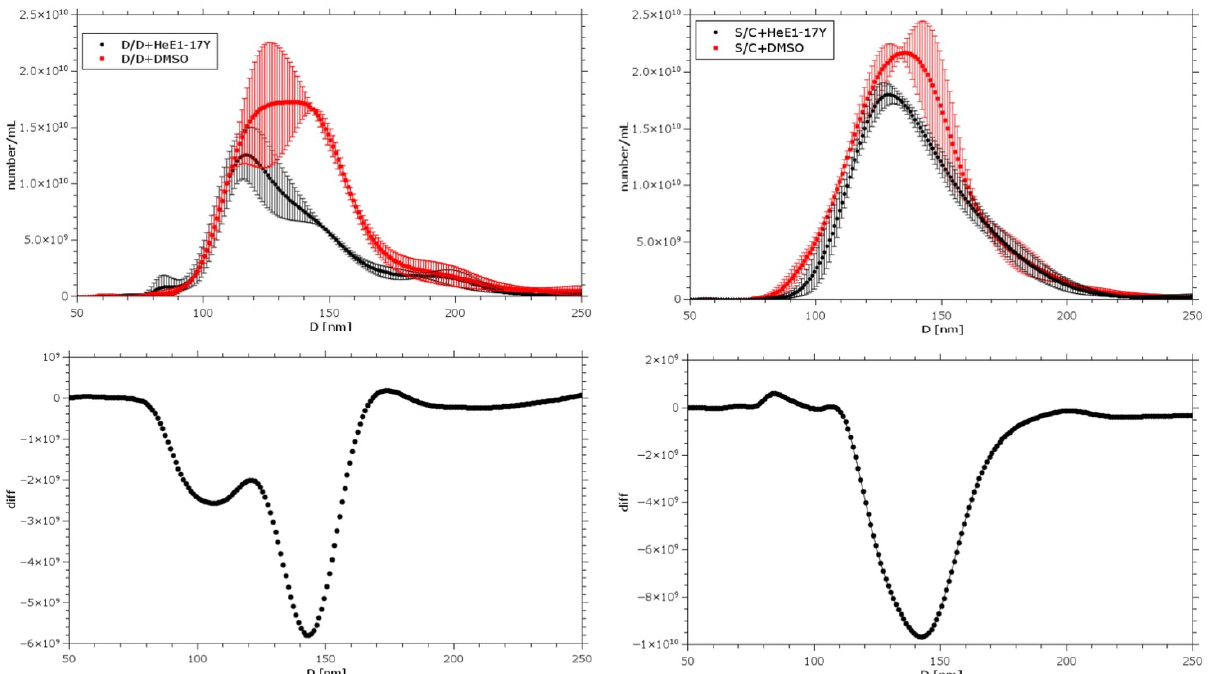
Figure 6. Liposomes are affected by HeE1-17Y. Comparison between the liposome diameter distribution after the addition of 17Y (200 µ M) or 2% DMSO (vehicle). Left and right D/D and S/C liposomes: distribution averaged on 3 experiments, with standard deviation. Lower panels: differences between the upper curves.